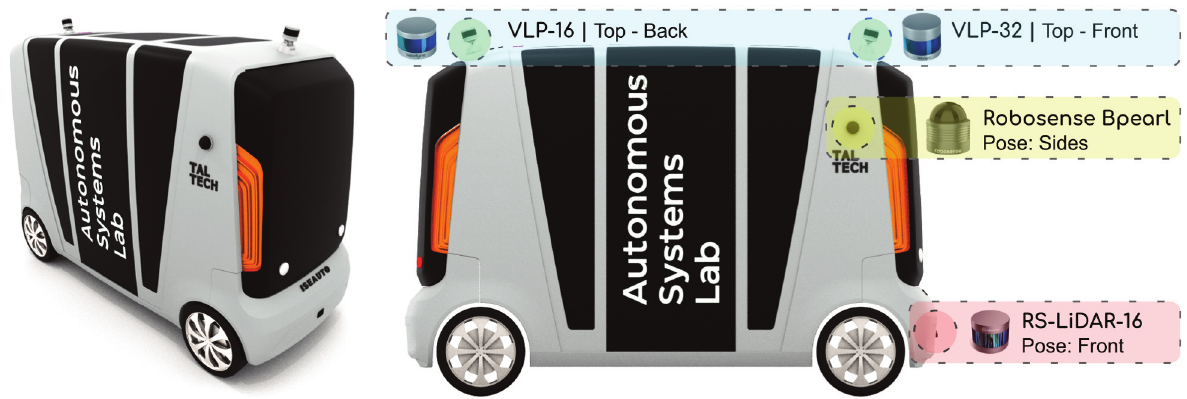
Fig. 3. iseAuto simulated model with different lidars